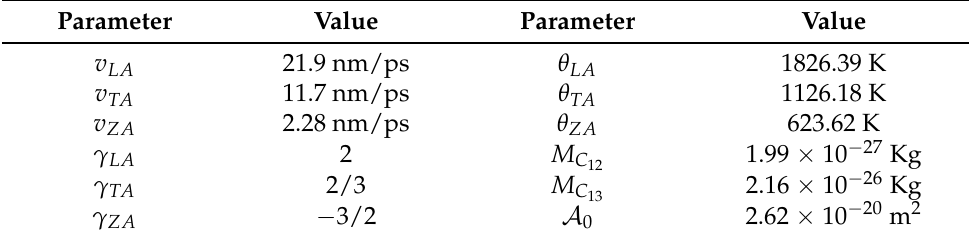
Table 5. Physical parameters for